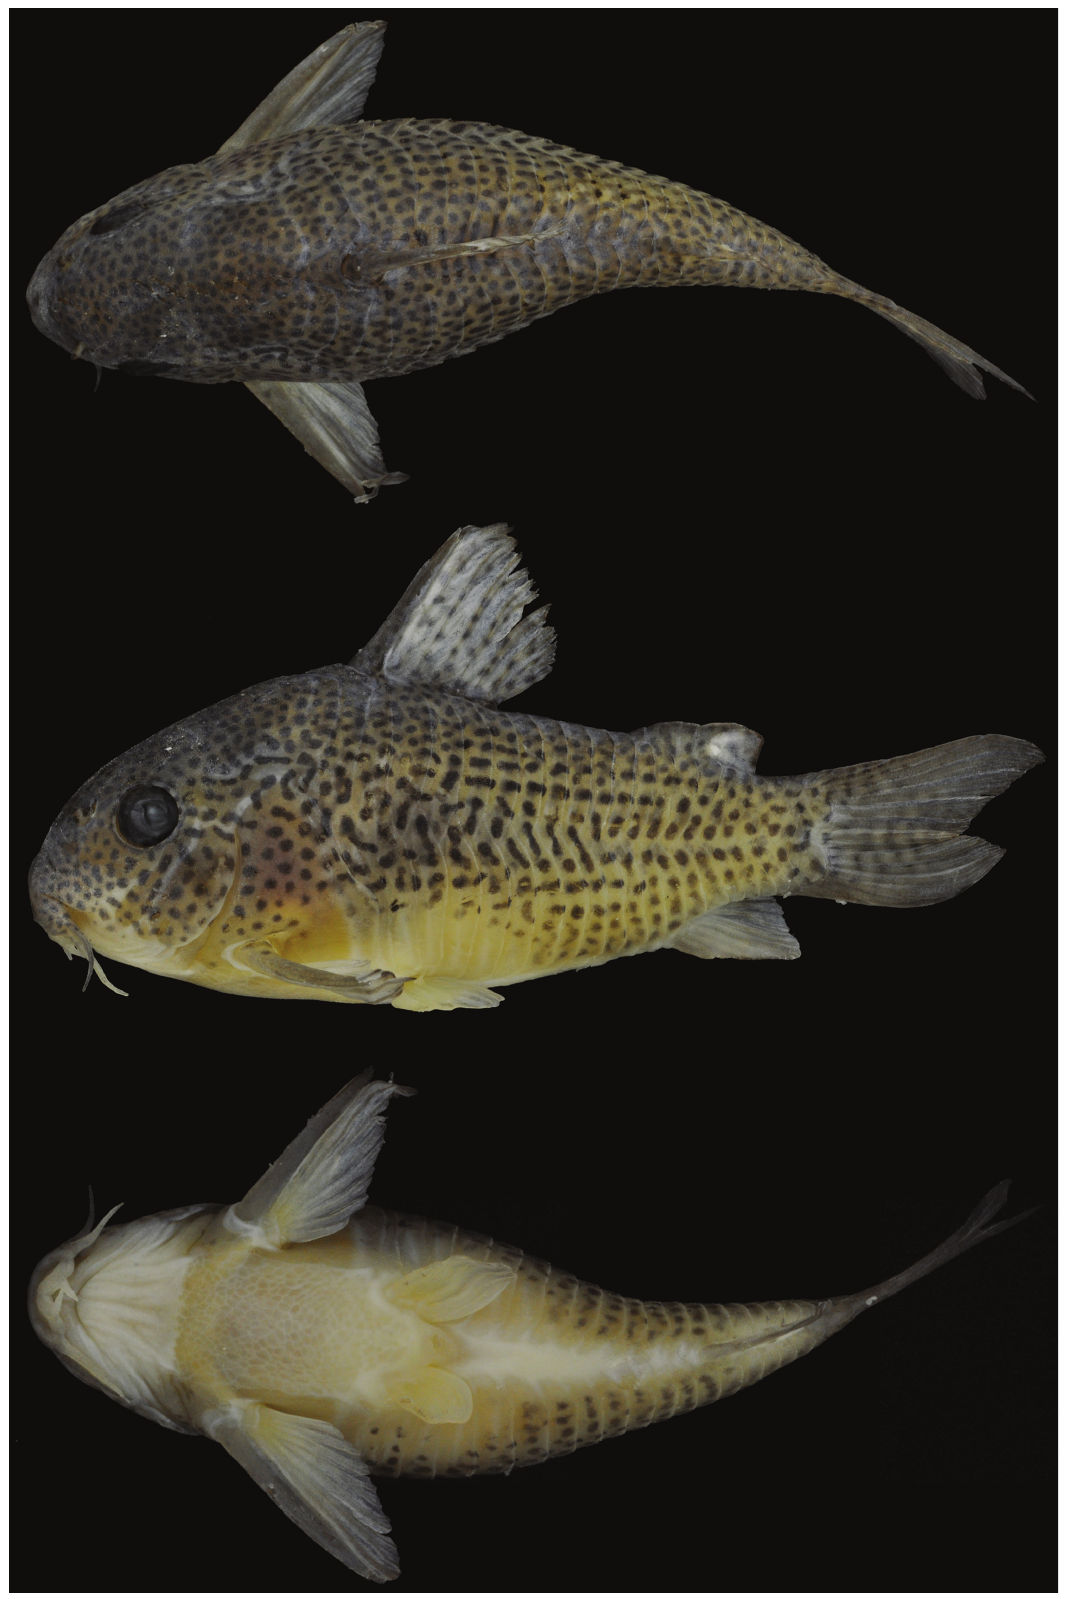
Fig. 1. Corydoras eversi , holotype, MNRJ 43195, 44.5 mm SL, Brazil, Goiás, Montes Claros de Goiás, unnamed stream tributary to the rio Araguaia, 15°53’10”S 51°41’34”W. Dorsal (top), lateral (middle) and ventral (bottom) views. Photo by Celso